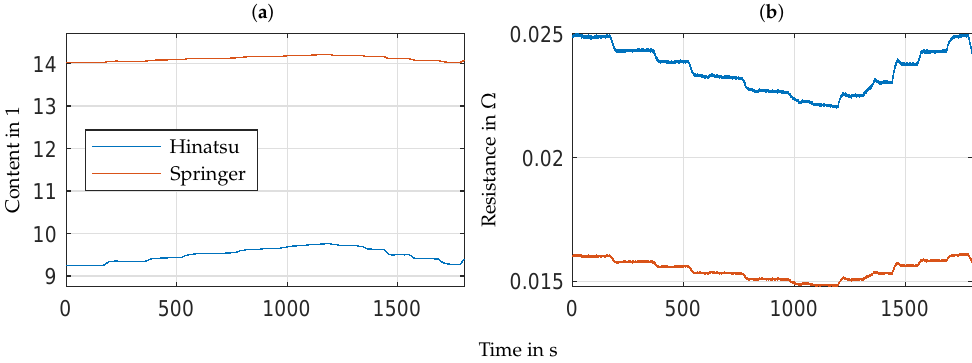
Figure 7. Comparison of membrane water contents ( a ) and ohmic membrane resistances ( b ) derived by Springer et al. [30] and Hinatsu et al. [29].